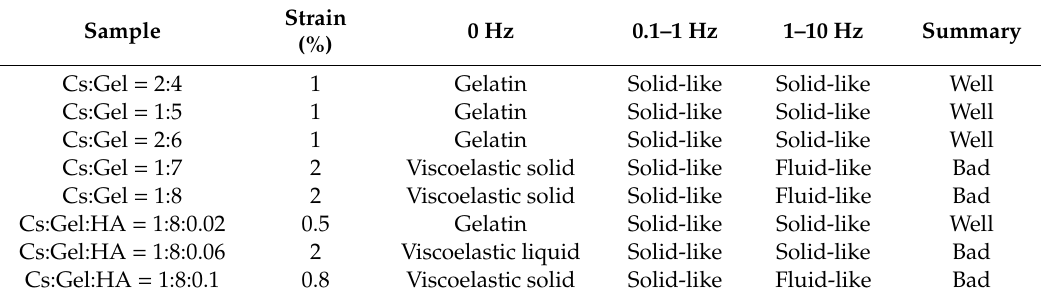
Table 4. Fluid behavior of various ratios of bio-ink.